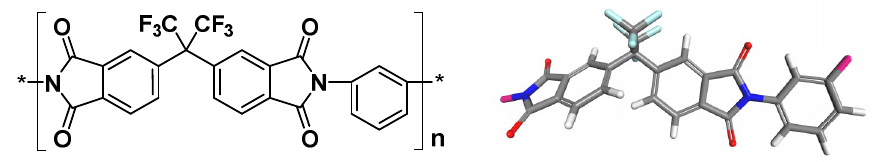
Figure 1. Chemical structure and 3D representation of the repeat unit of 4,4′-(hexafluoroisopropylidene)diphthalic dianhydride (6FDA)-m-phenylenediamine (mPDA) polyimide.